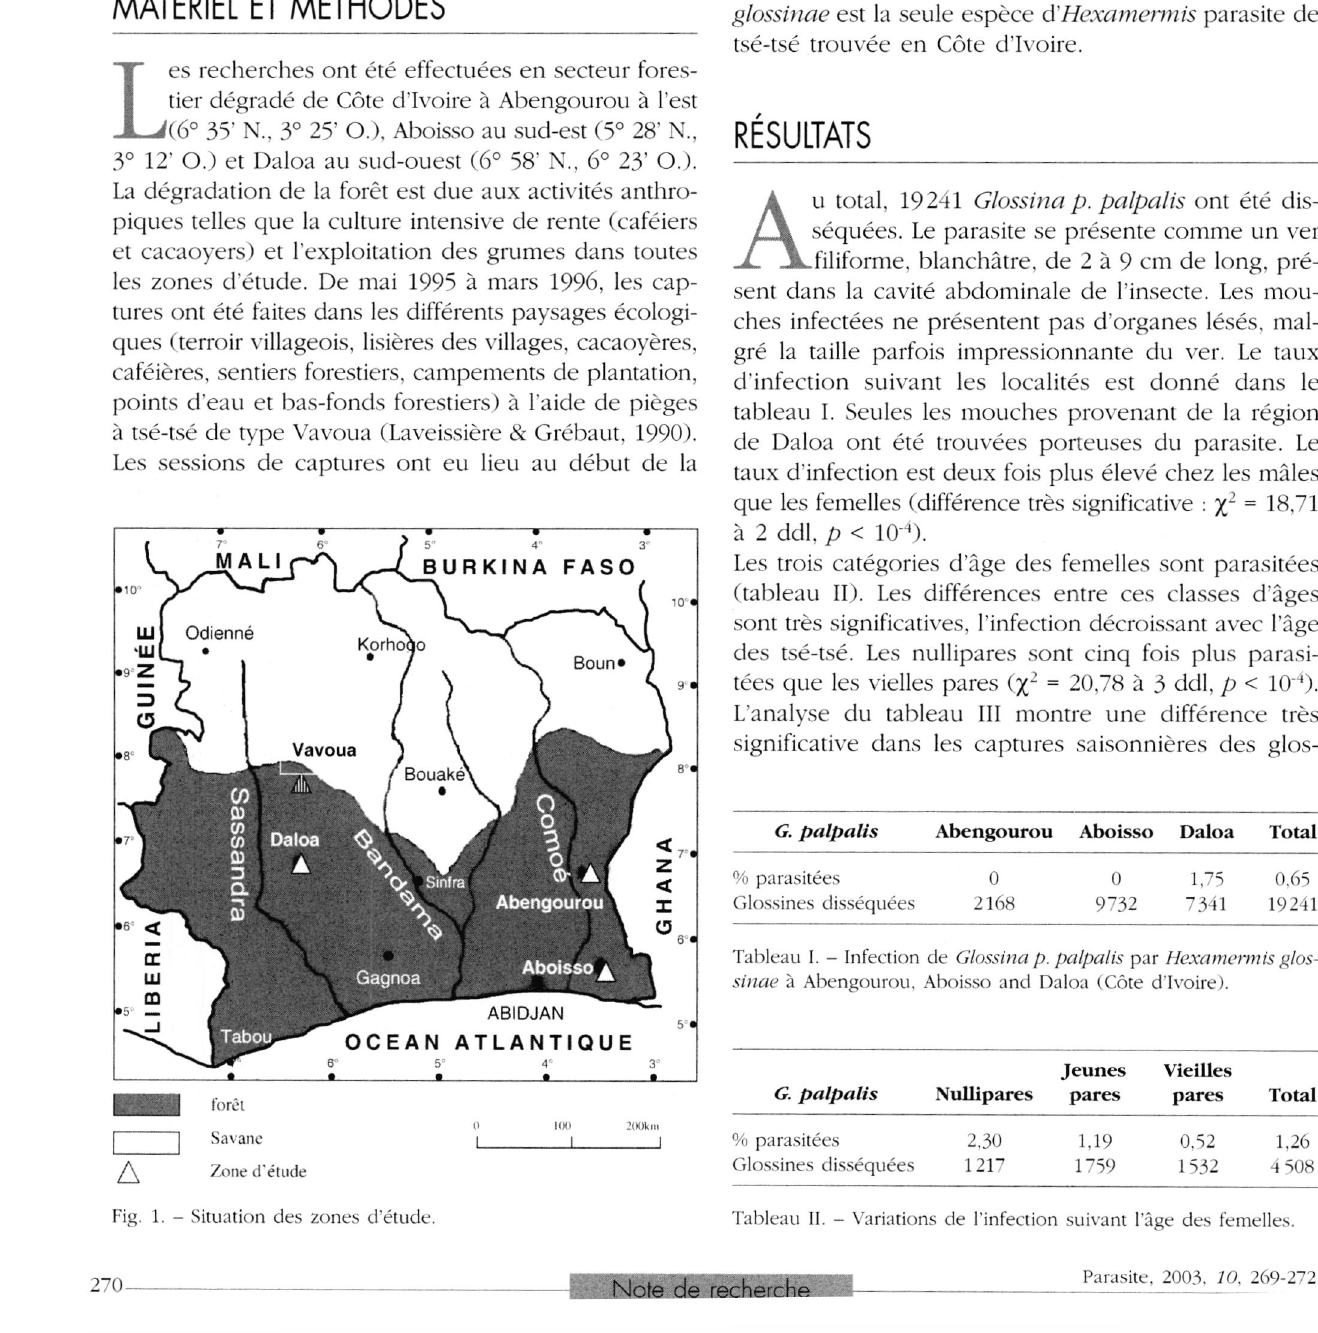
Tableau I. - Infection de Glossina p. palpalis par Hexamermis